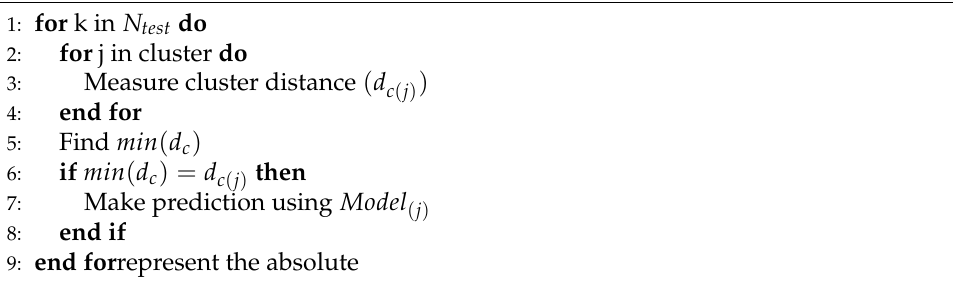
Algorithm 2 Dynamic Regressor Selection Testing Phase